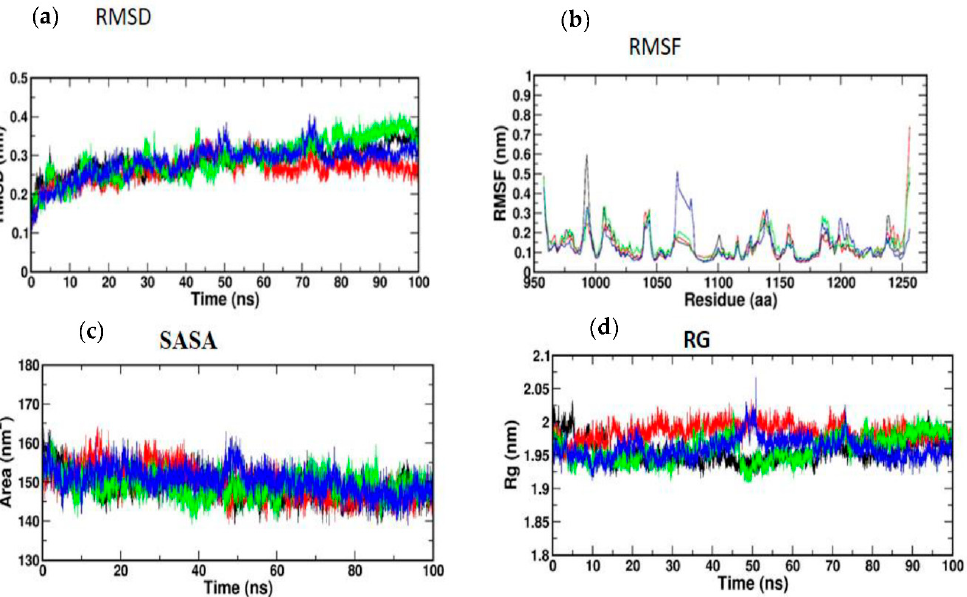
Figure 8. ( a ) RMSD; ( b ) RMSF; ( c ) SASA; ( d ) RG of IRS-1 protein with the top three compounds. Kaempferol shown in red; quercetin (green); trans-ferulic acid (blue).